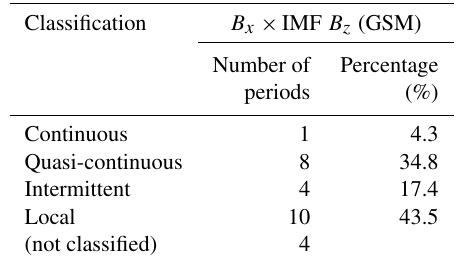
Table 3. Correlation distribution characteristics between IMF B z andeomagnetic B x g component during